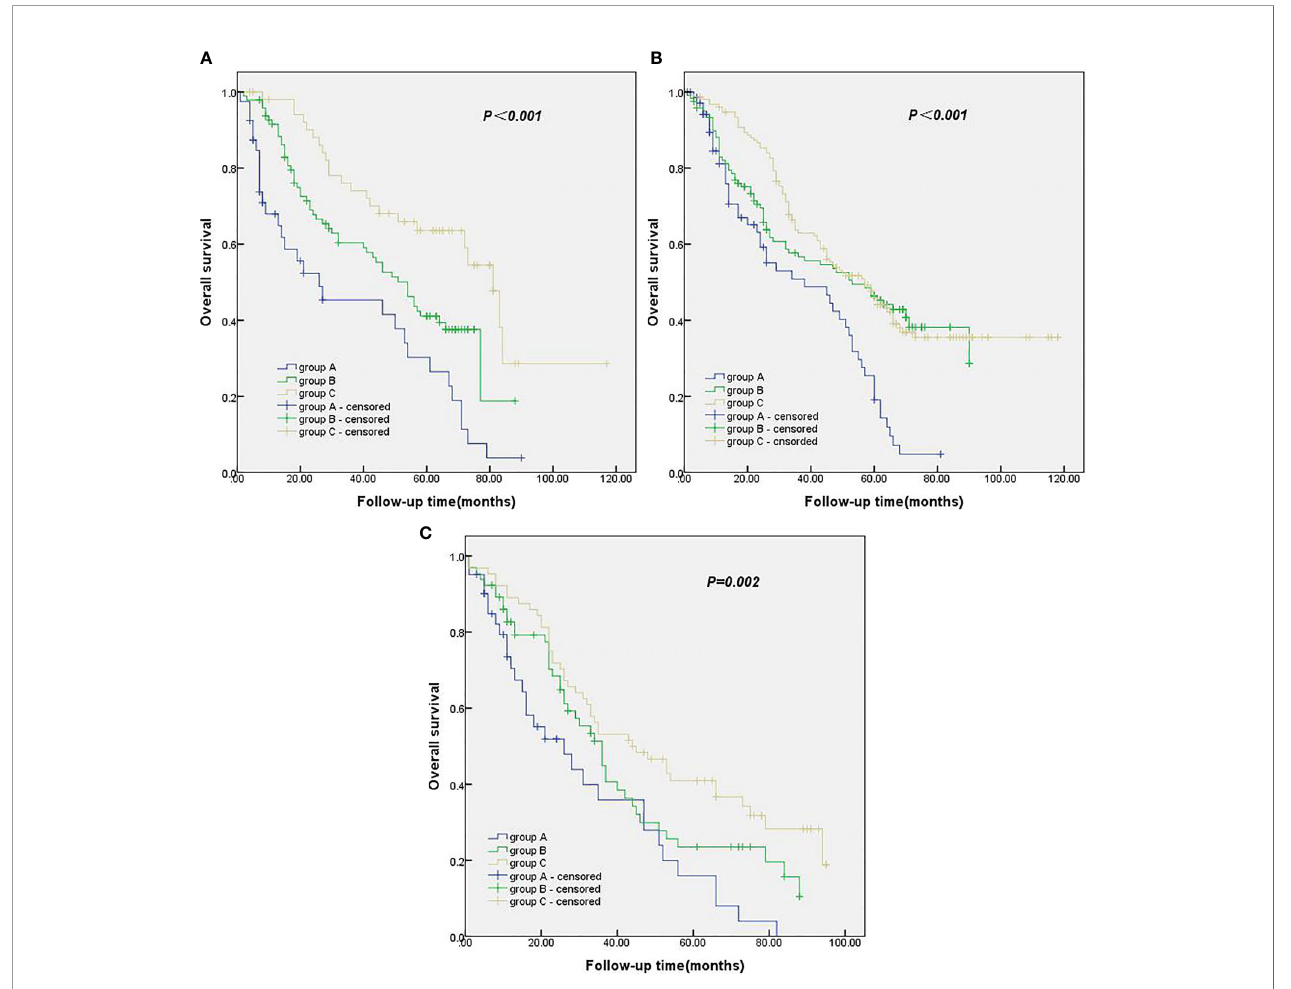
FIGURE 3 | (A) Kaplan-Meier survival curves of groups A, B and C in T1 stage. (B) Kaplan-Meier survival curves of groups A, B and C in T2 stage. (C) Kaplan-Meier survival curves of groups A, B and C in T3